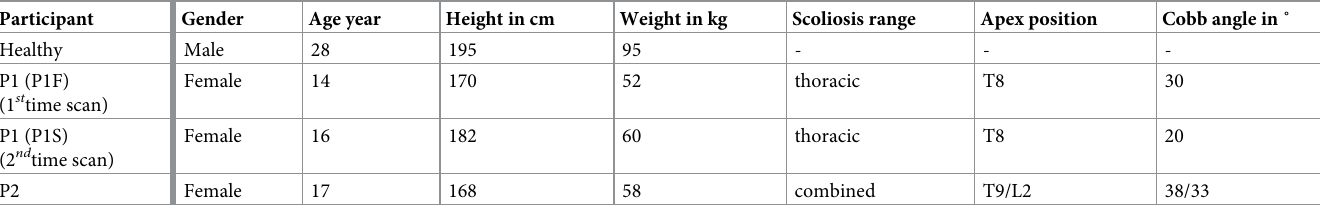
P1 and P2 indicate two patients. P1F: 1 st time scan of the patient P1, P1S: 2 nd time scan of the patient P1. T8 and T9 indicate the eighth and ninth thoracic vertebrae respectively. L2 indicates the second lumbar vertebra.